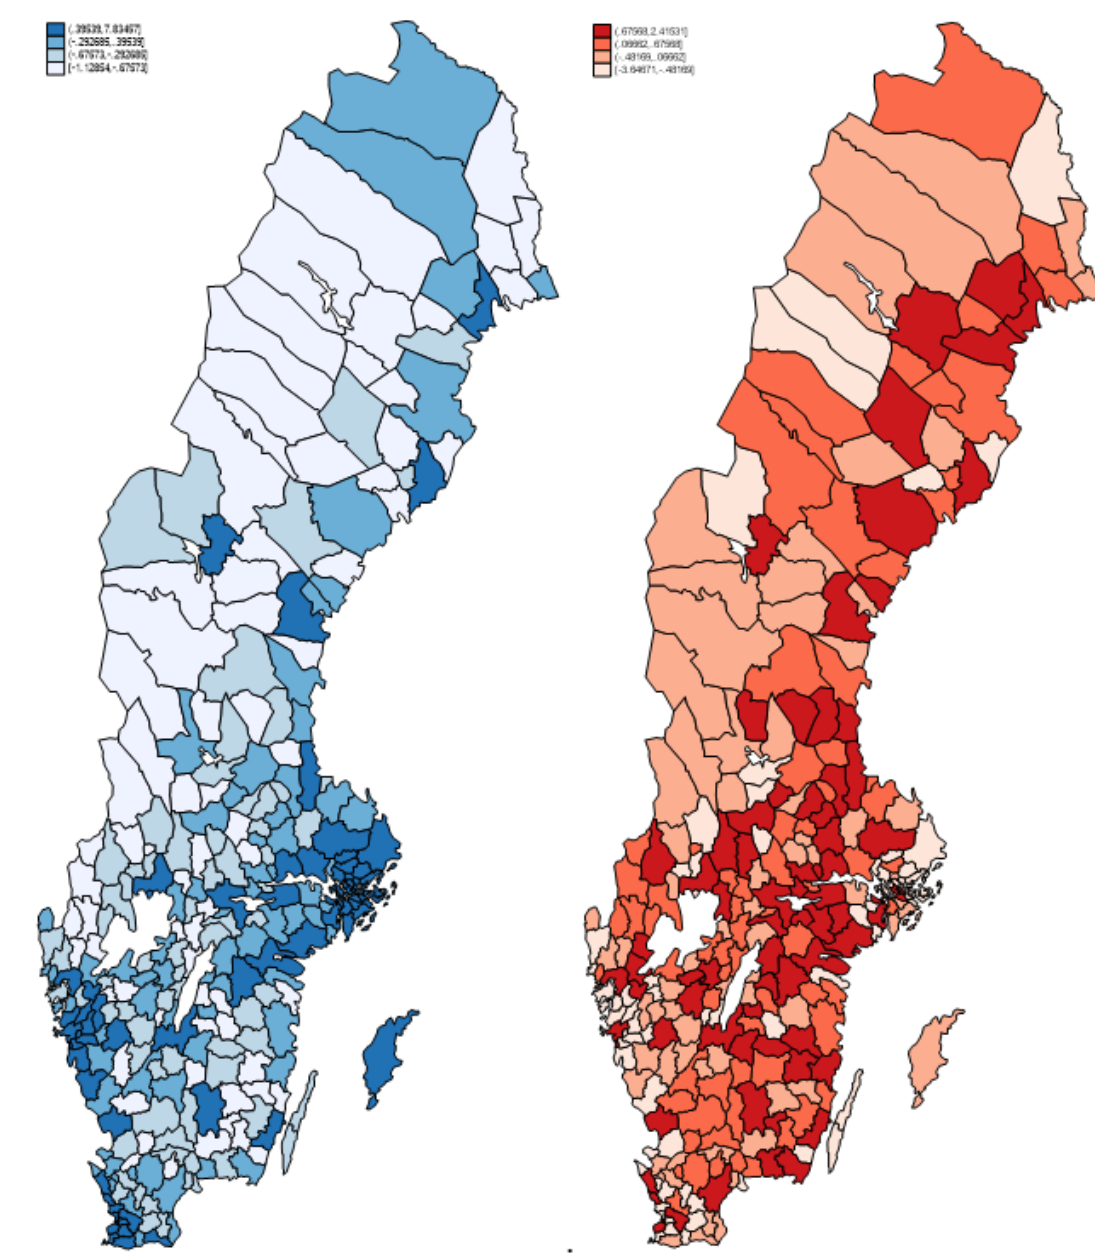
Figure 4. Housing components (hh1 – hh2) distribution in space. Component h1 (red) is mainly concentrated along the coasts of Sweden, including the metropolitan regions, while component h2 (green) is more spatially concentrated in municipalities in and around the metropolitan regions. Component h3 (blue), on the other hand, is primarily concentrated in the middle and southern parts of Sweden, excluding the metropolitan regions. Component h4 (purple) is predominantly concentrated in cen- tral Sweden, excluding the metropolitan regions, and component h5 (grey) is primarily concentrated in northern Sweden ’ s interior.